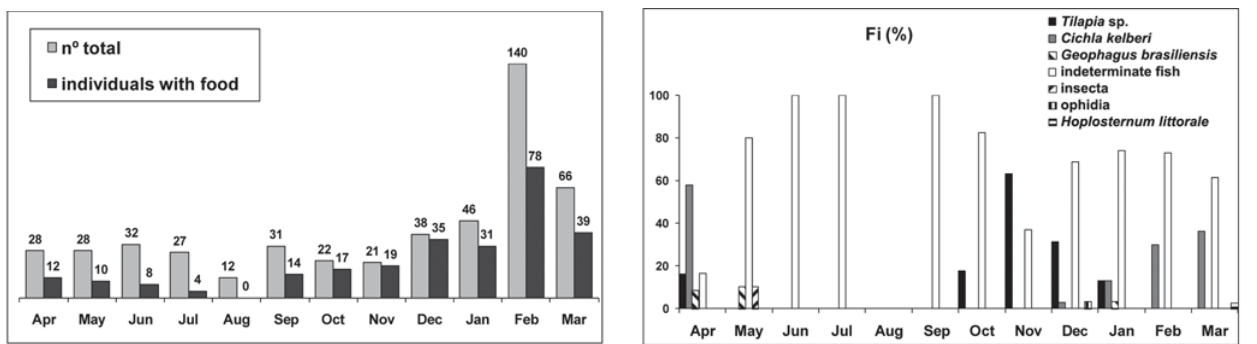
Fig. 3. Frequency of Occurrence (Fi) of the food items of Cichla kelberi during the collection period.